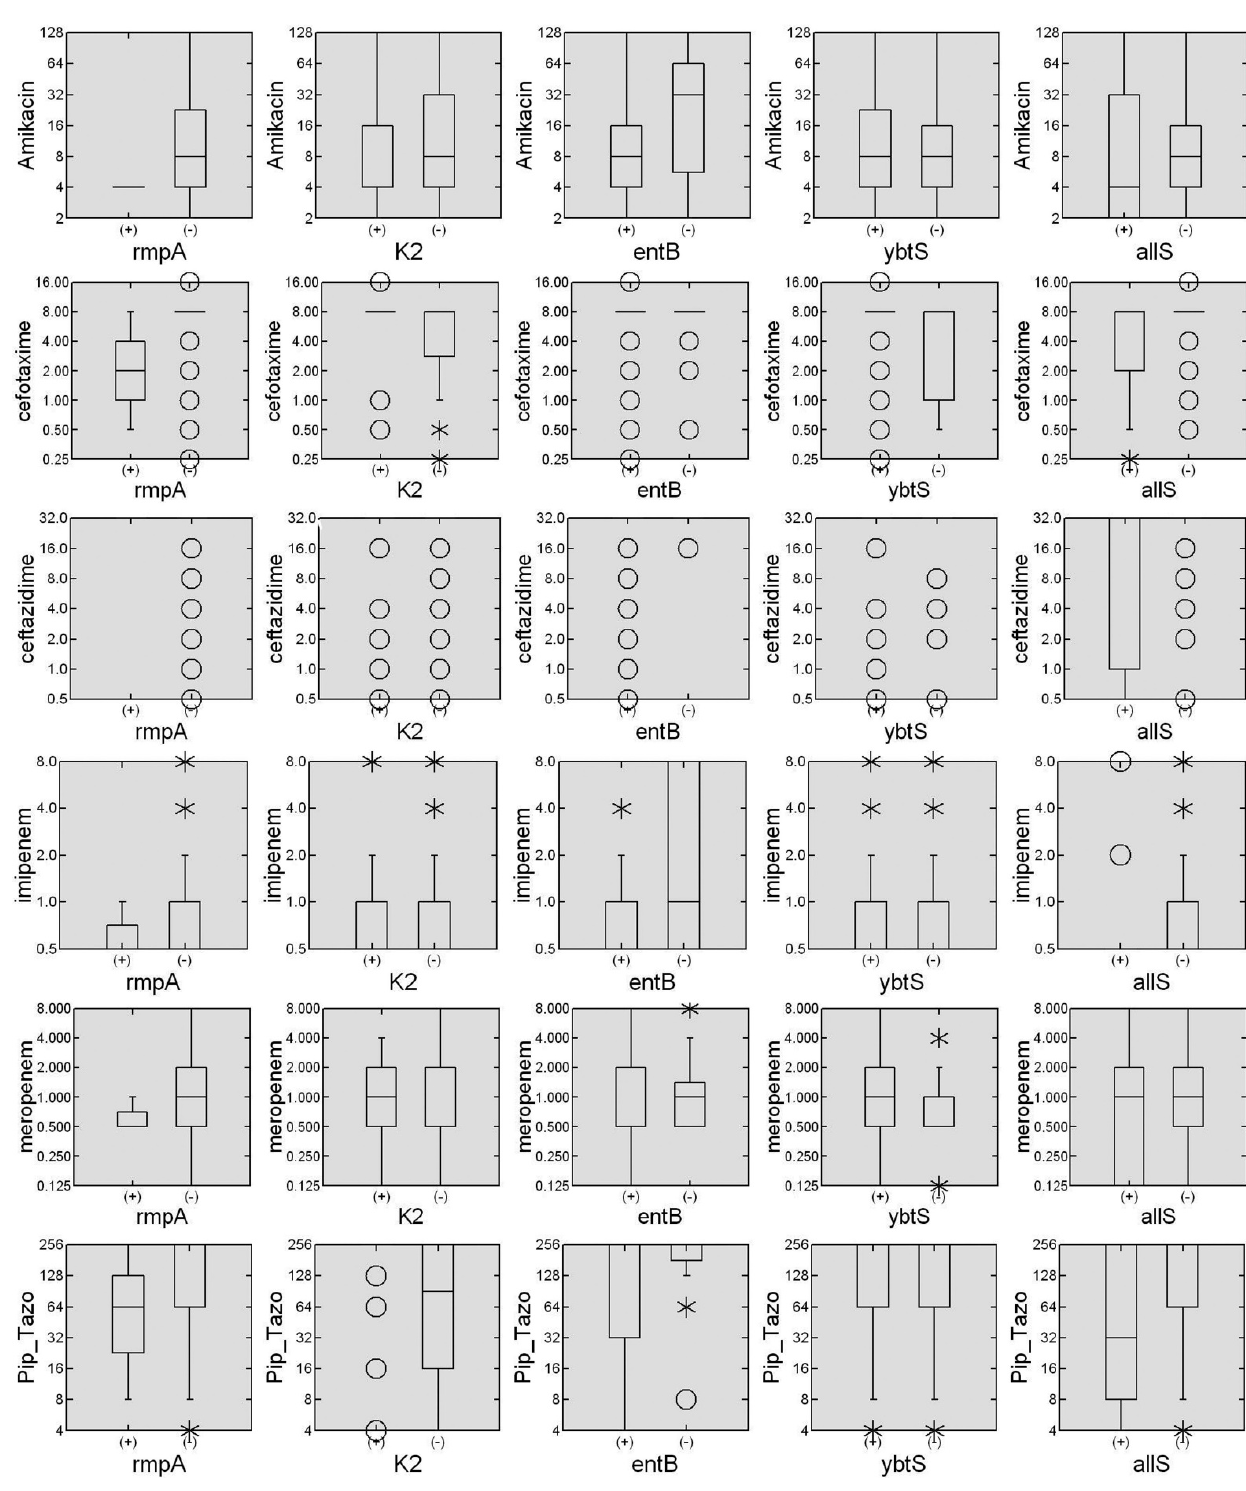
Figure 2. Association of virulence genes in the measurement of median MIC. The box diagrams created with the Systat 13 software summarize the MIC measures for six commonly used antibiotics, stratified by the presence or absence of each of the six virulence genes. The data are presented as mg/L in a Log 2 scale of MICs for each antibiotic stratified by the presence (+) or absence ( − ) of each virulence gene. The horizontal lines represent the median and the frequency limits between 25 and 75% of the individuals, the hollow dots represent single individuals, and the asterisks represent small groups of individuals.